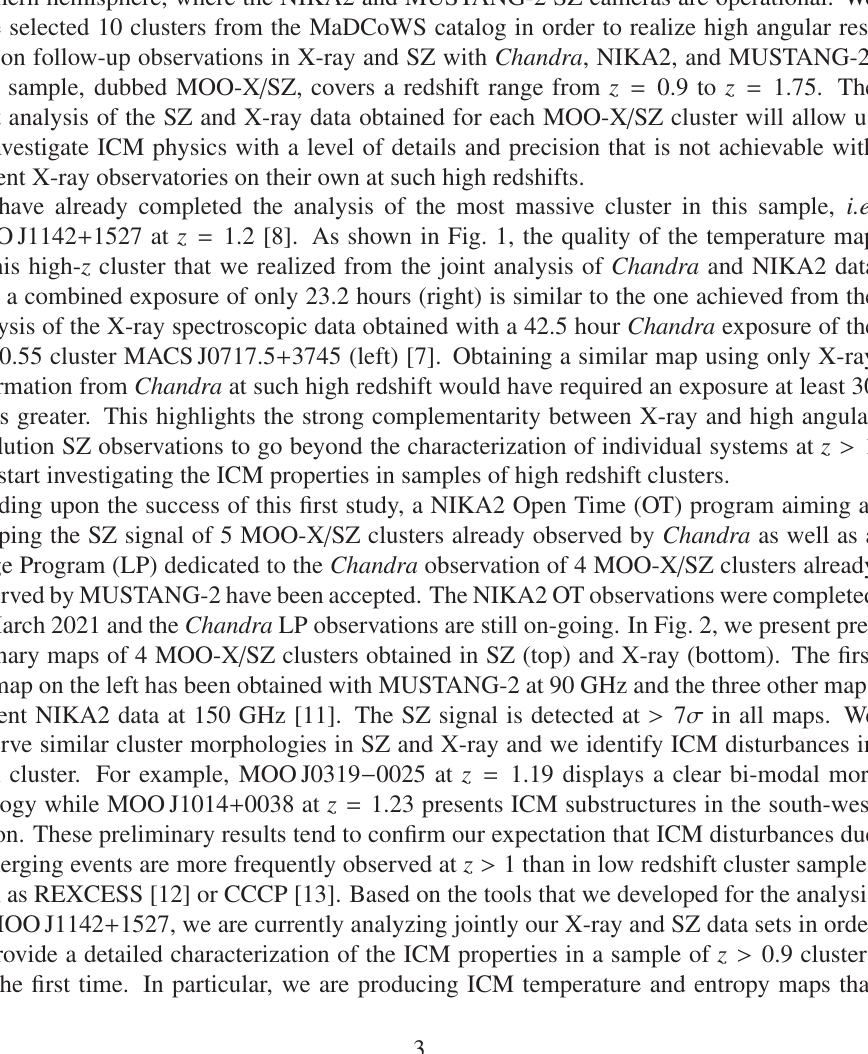
Figure2. Temperaturemaps. Top :Spectroscopictemperaturederivedfrom Chandra ( T CXO ,leftpanel)andfromXMM- Newton ( T XMM ,right panel)areshown. Bottom :NIKAandXMM Newton imagingderivedtemperature, T SZX ,formodelM1(leftpanel)andmodelM3a(rightpanel) areshown.Thesemapsarecorrectedforthezerolevel. central region in the direction of the subclusters ( ⇠ 1200 kpc) andalsoincreaseswithradius.ModelM3bprovidesalowerlimit for ` e↵ ,increasingfrom ⇠ 800 kpcnearthecentreto ⇠ 1200 kpc at1arcmin.